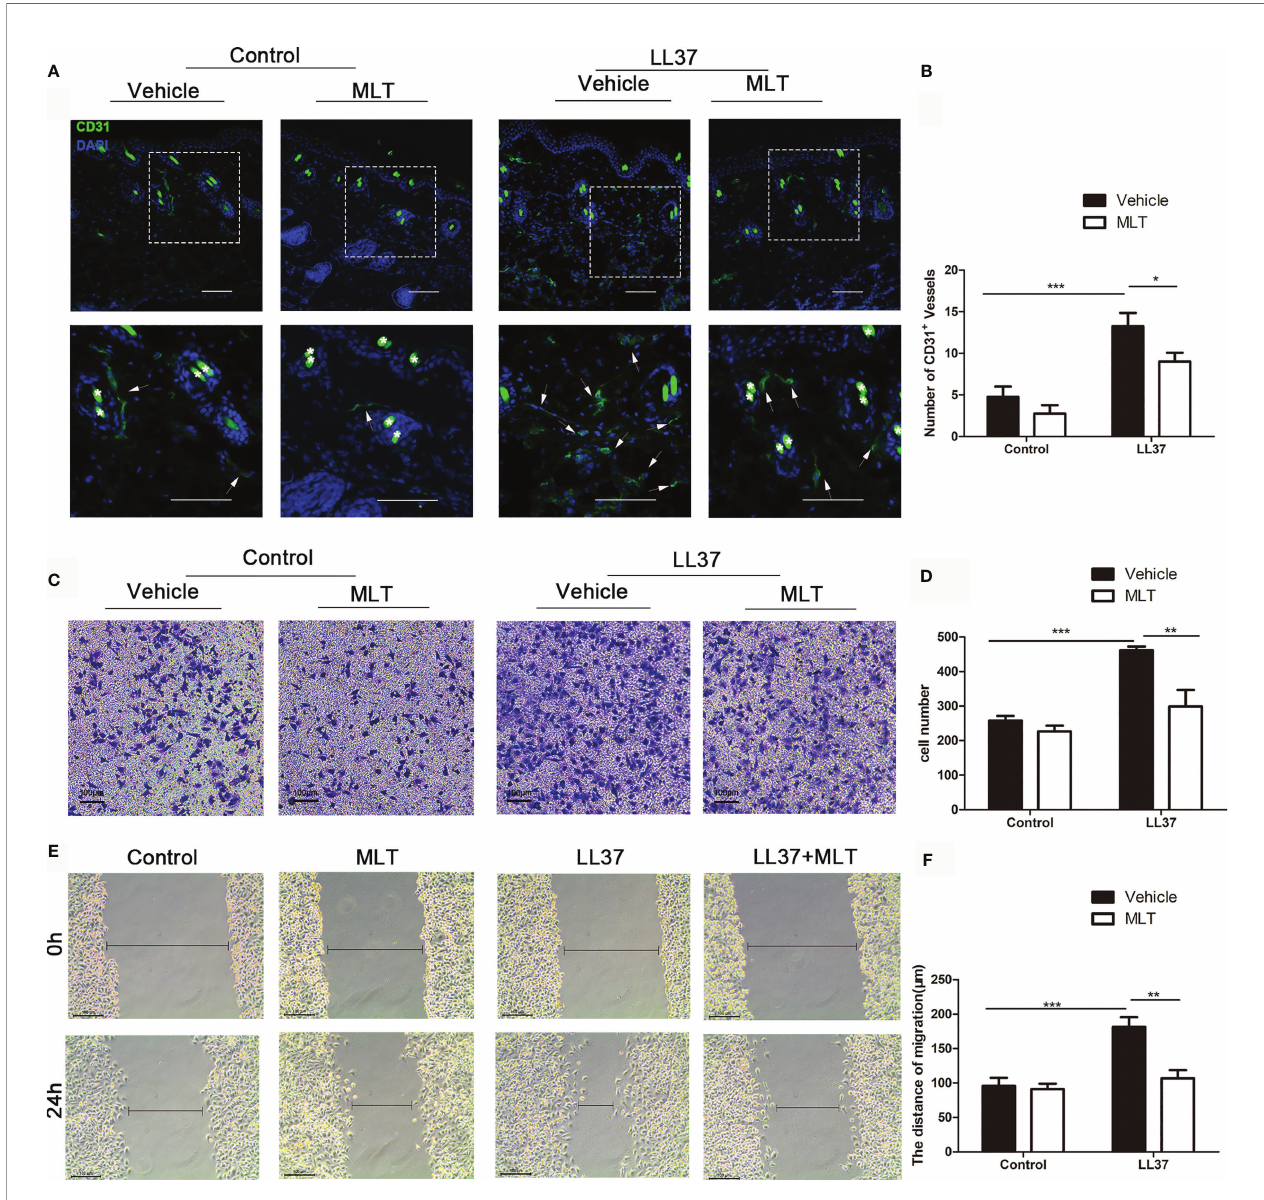
FIGURE 8 | MLT suppresses angiogenesis in rosacea. (A) Immunostaining of CD31 + cells in rosacea-like lesions. Scale bar: 50 m m. (B) The CD31 + microvessels were quanti fi ed. (C, D) The transwell assay was used to detect the chemotaxis ability of HUVEC cells. (E, F) The transwell assay was used to detect the migration ability of HUVEC cells. All results are representative of at least three independent experiments. Data expressed as individual values with mean ± SEM. * P < 0.05, ** P < 0.01, *** P < 0.01. One-way ANOVA with Bonferroni ’ s post-hoc test or two-tailed unpaired Student ’ s t -test was